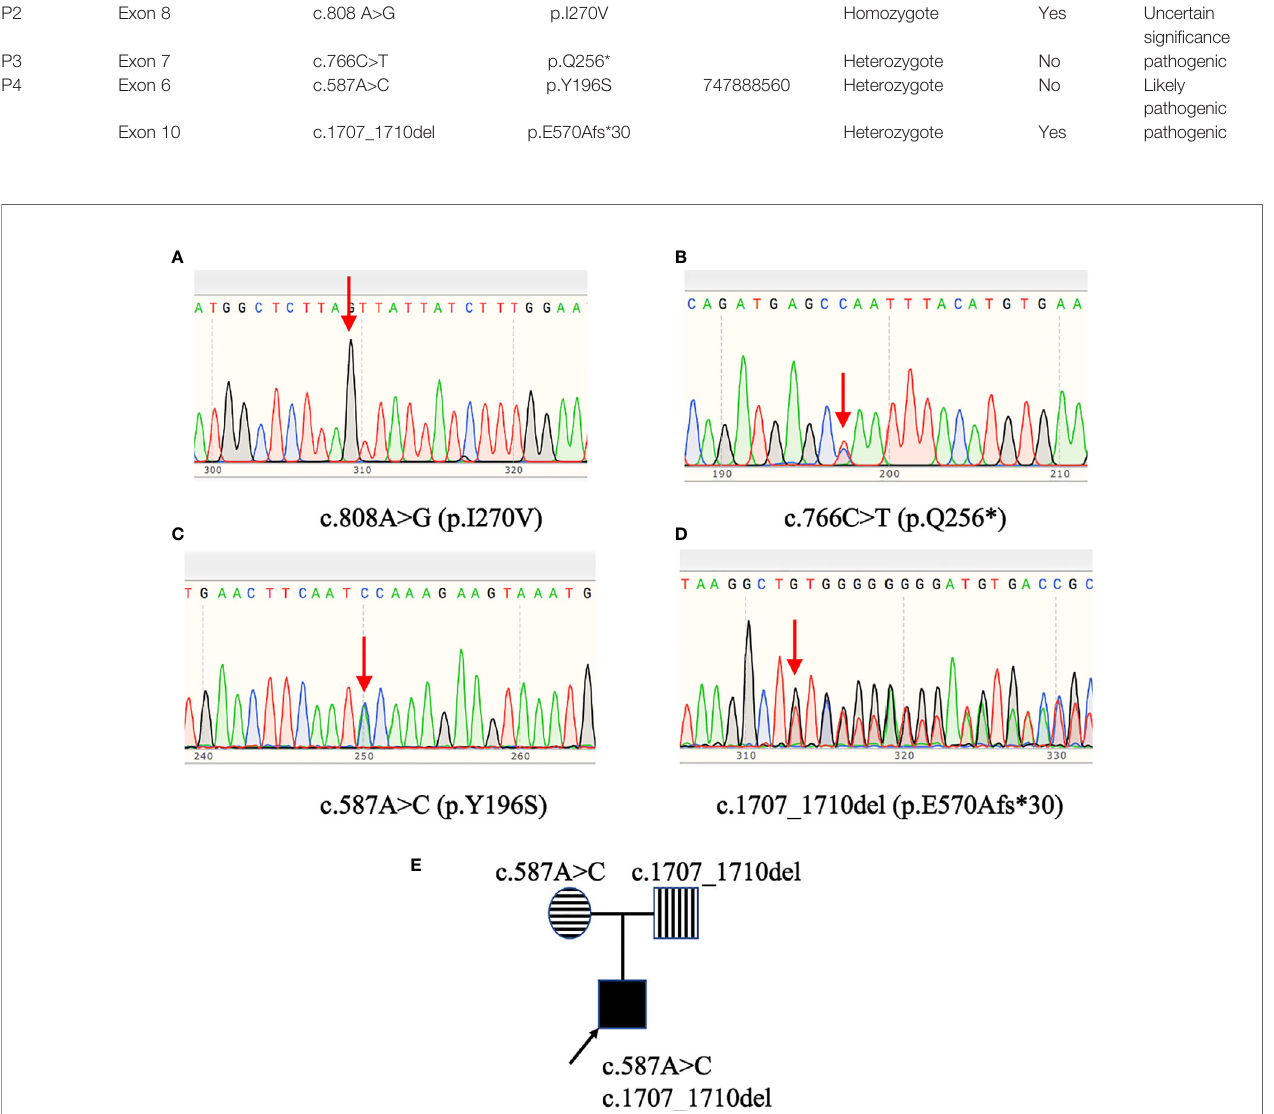
FIGURE 1 | GHR gene variants in patients with Laron syndrome. Patient 2 (A) carried the c.808A>G (p.I270V) homozygous mutation. Patient 3 (B) harbored the c.766C>T (p.Q256*) heterozygous mutation. Patient 4 (C, D) had GHR gene compound heterozygous mutations: c.587A>C (p.Y196S) and c.1707_1710del (p.E570Afs*30). Pedigree analysis of patient 4 (E) revealed that the c.587A>C variant was inherited from his mother, while the c.1707_1710del variant was inherited from his father.